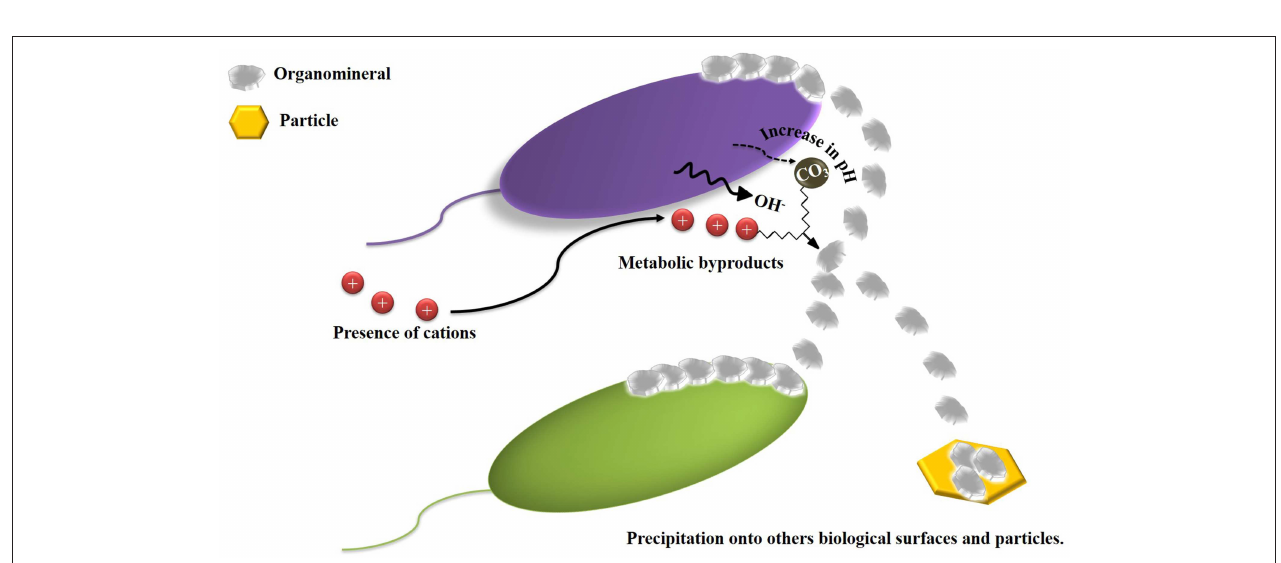
FIGURE 2 | Schematic diagram of BIM, precipitation of biominerals is induced due to the interaction between metabolic products of microorganisms and inorganic compounds present in environment. Adapted from Weiner and Dove (2003).